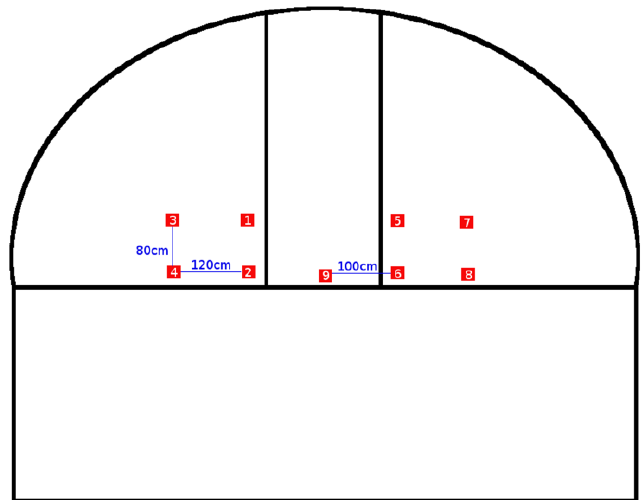
Figure 2. Distribution of the slave nodes along the